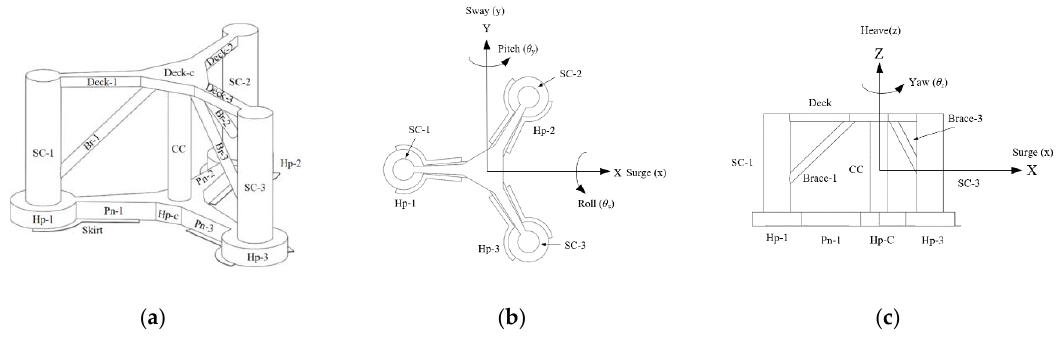
Figure 1. Schematic of the semi-submersible platform. ( a ) Bird view, ( b ) top view and ( c ) side view. Table 1. Dimension and hydrostatic properties of the 1:60 scale semi-submersible platform.